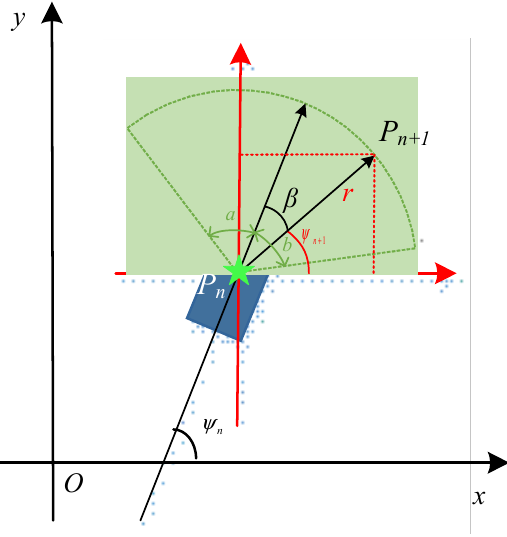
Figure 10. Variable searching region depending on the current ship status.